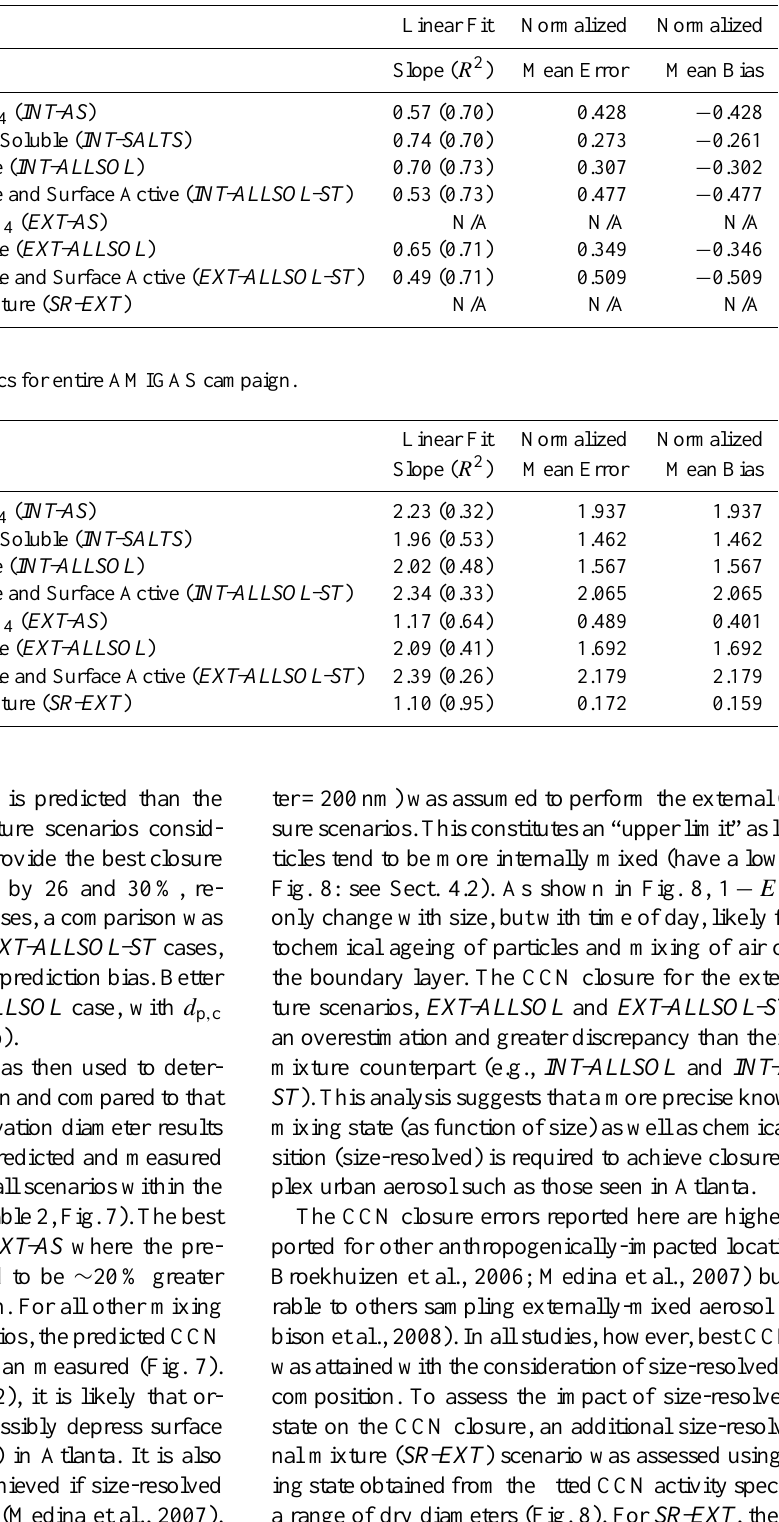
Table 1. “Critical” dry particle diameter closure analysis error metrics for entire AMIGAS campaign.